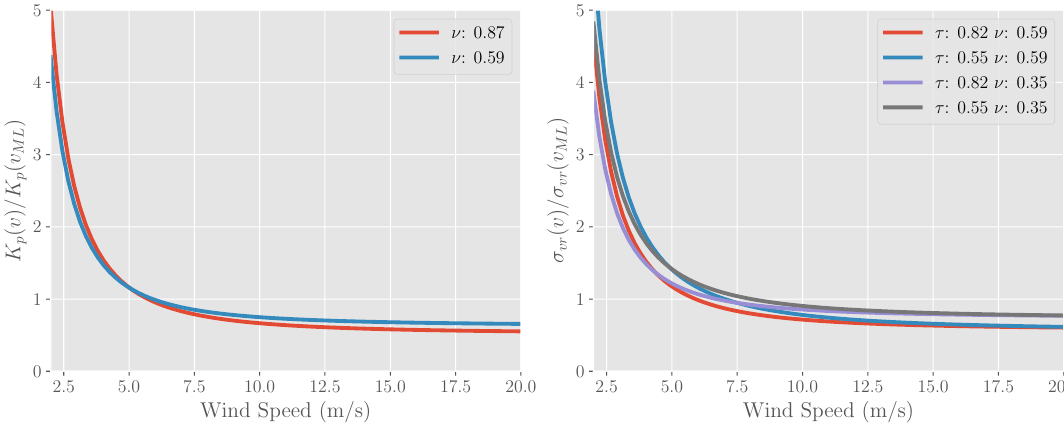
Figure 6. (left) Ratio of K p as a function of wind speed to K p for the maximum-likelihood wind velocity for the optimal value of ν and a lower value representing lower bandwidth: the performance is robust to picking the bandwidth; (right) ratio of the radial velocity as a function of wind speed to the radial velocity at the maximum-likelihood wind for various values of τ